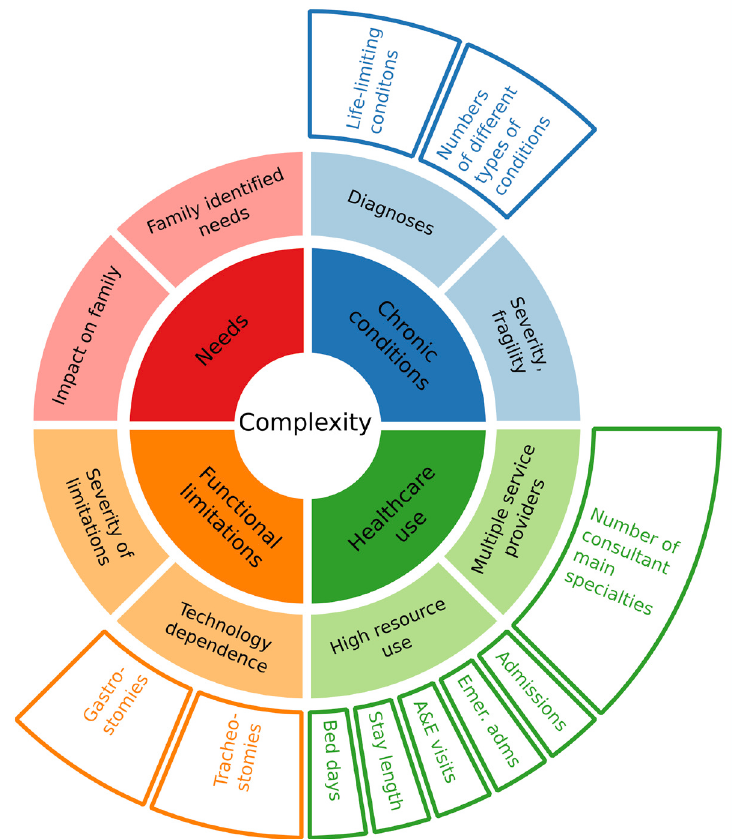
Figure 2. Conceptualisation of complexity and relevant data. Inner two rings, adapted from earlier work 20 , show conceptualisation of complexity. Outer ring shows relevant measures in the data.